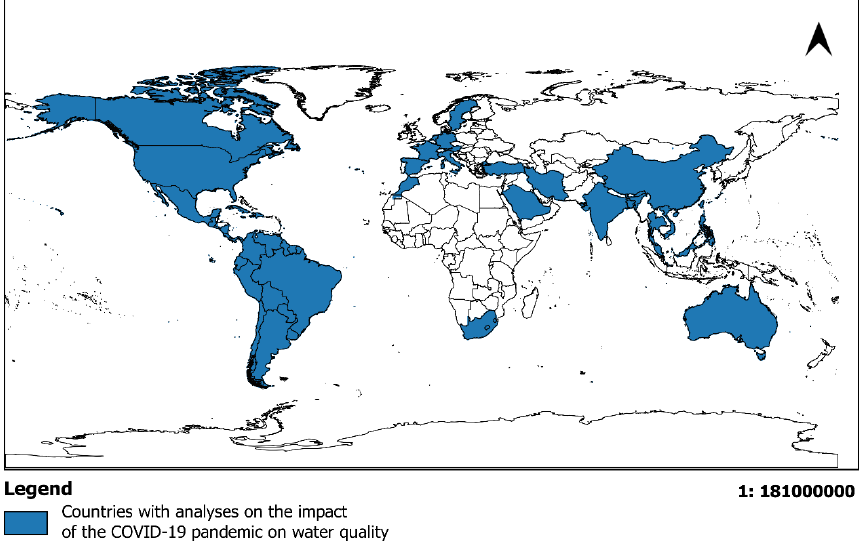
Figure 1. Countries with analyses on the COVID-19 impact on water quality.